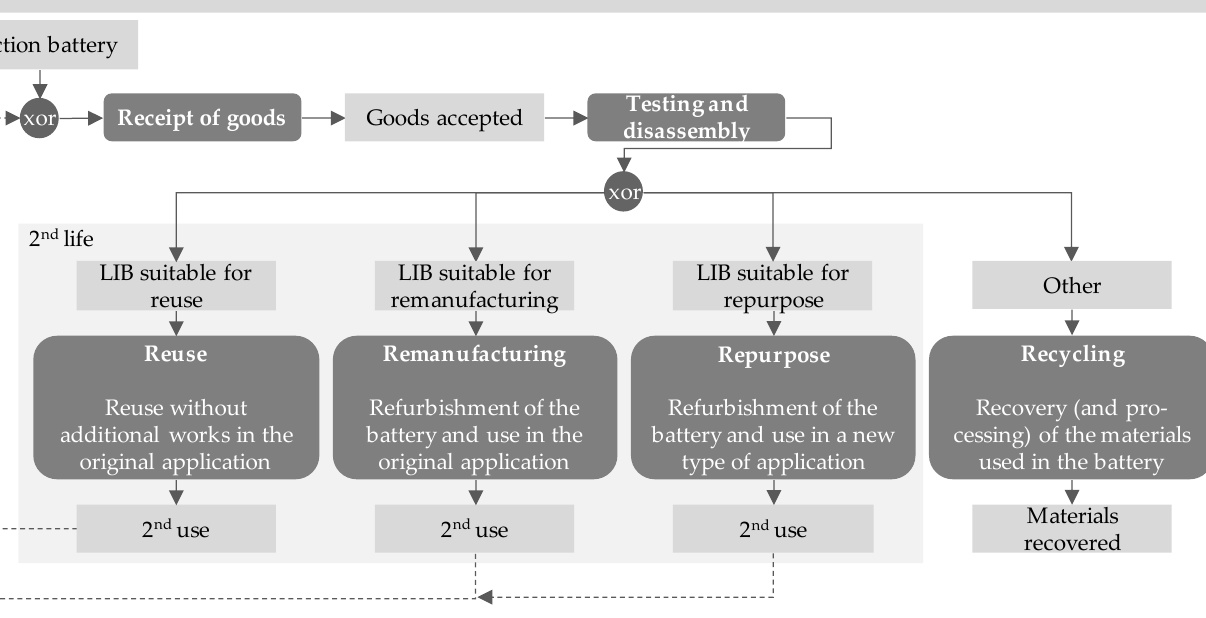
Figure 2. The process of second-life determination [5].